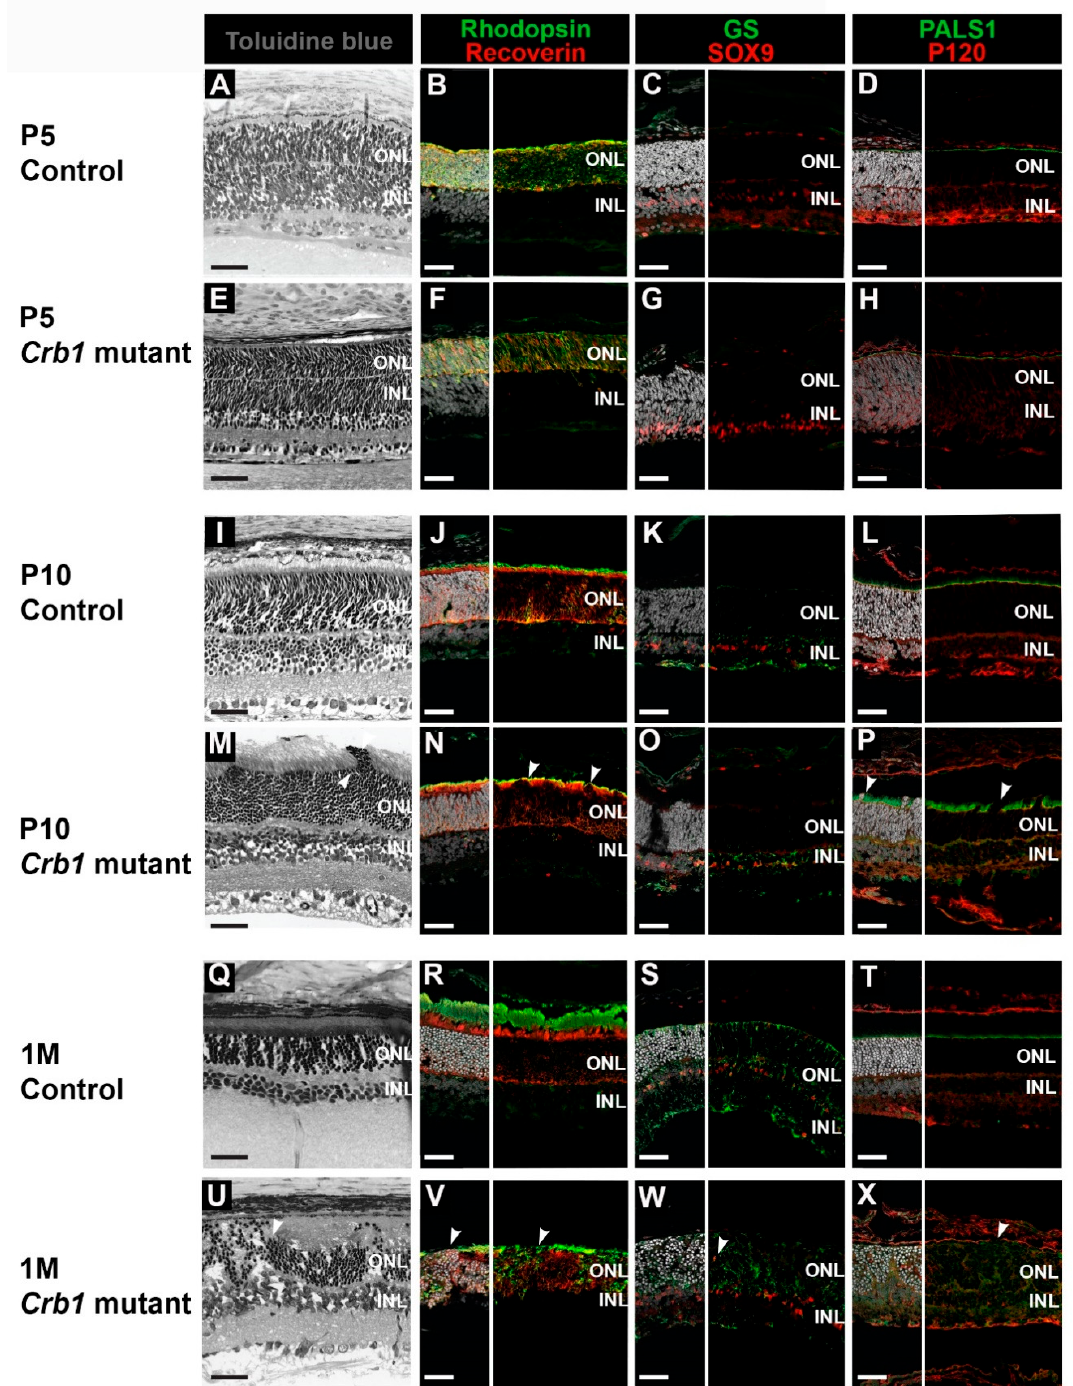
Figure 2. Retinal degeneration is observed from postnatal day 10 retinas of Crb1 mutant rats. Light microscopy of toluidine blue-stained retinal sections from P5, P10 and 1-month-old control ( A , I , Q ) and Crb1 mutant rats ( E , M , U ). Immunohisto- chemistry staining of P5, P10 and 1-month-old retinal sections, with recoverin and rhodopsin ( B , F , J , N , R , V ), glutamine synthetase (GS) and SOX9 ( C , G , K , O , S , W ) and PALS1 with P120-catenin ( D , H , L , P , T , X ). No abnormalities were observed in the control retina ( A – D , I – L , Q – T ). In the Crb1 mutant rats, all retinal layers were formed and properly laminated at P5 ( E – H ). From P10 onwards, degeneration at the foci was observed in the Crb1 mutant rat retina by photoreceptor nuclei protrusions into the photoreceptor segment layers, misplaced Müller glial cells (MGCs) and disruption of the outer limiting membrane (OLM) ( M – P , U – X ; arrowheads). At least n = 2 eyes were used per time point. GCL, ganglion cell layer; INL, inner nuclear layer; ONL, outer nuclear layer; RPE, retinal pigment epithelium. Scale bar: 40 µm.